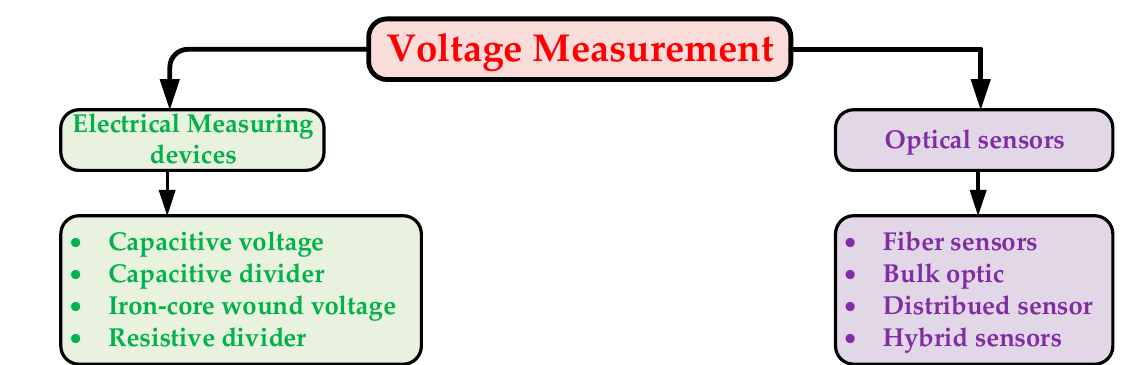
Figure 4. Classification of current sensor technologies.